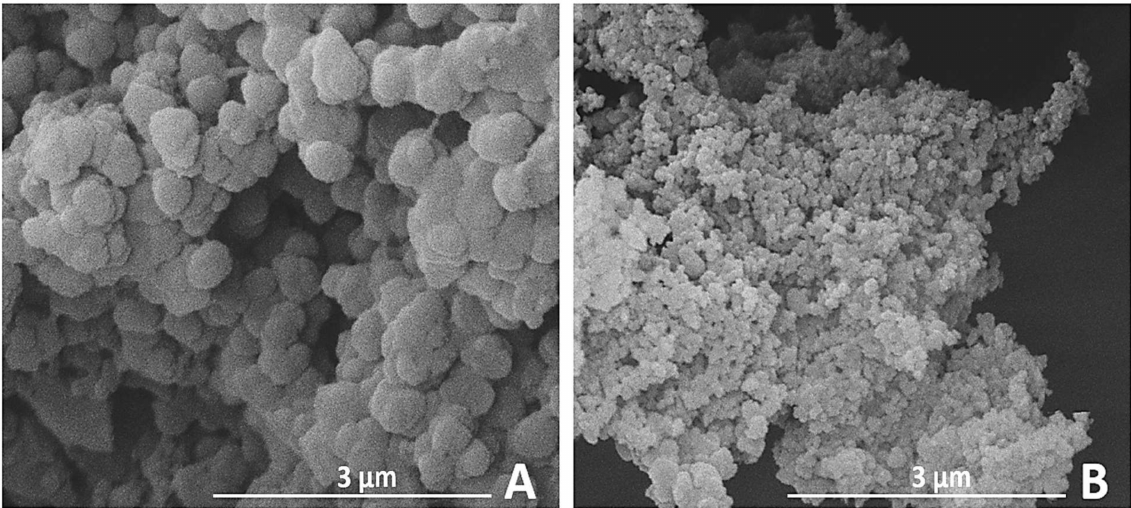
Figure 3. SEM images at 50,000 × magnification of ABT01 ( A ) and ABT02 ( B ).